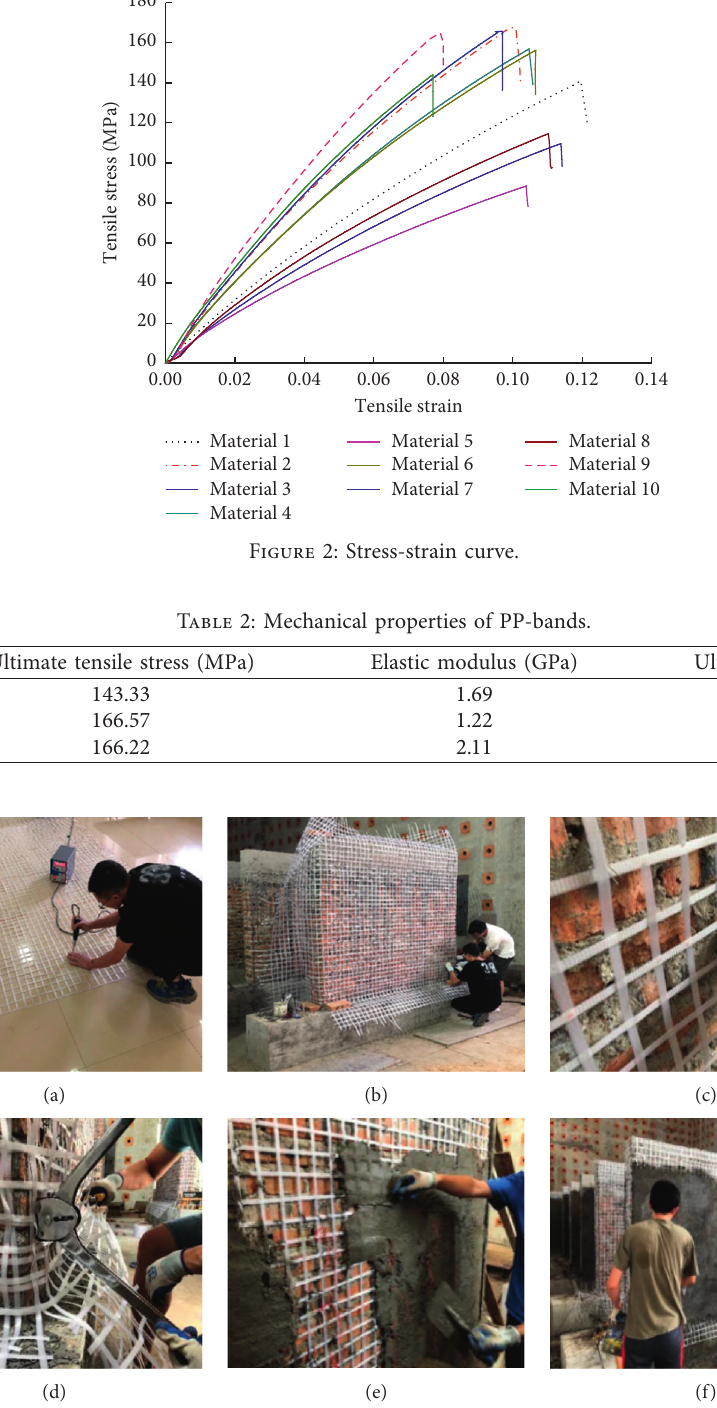
Figure 3: Strengthening process. (a) Weaving PP-band mesh, (b) laying PP-band, (c) PP-band and wall close, (d) tightening the PP-band, (e) smearing cement mortar, and (f) watering